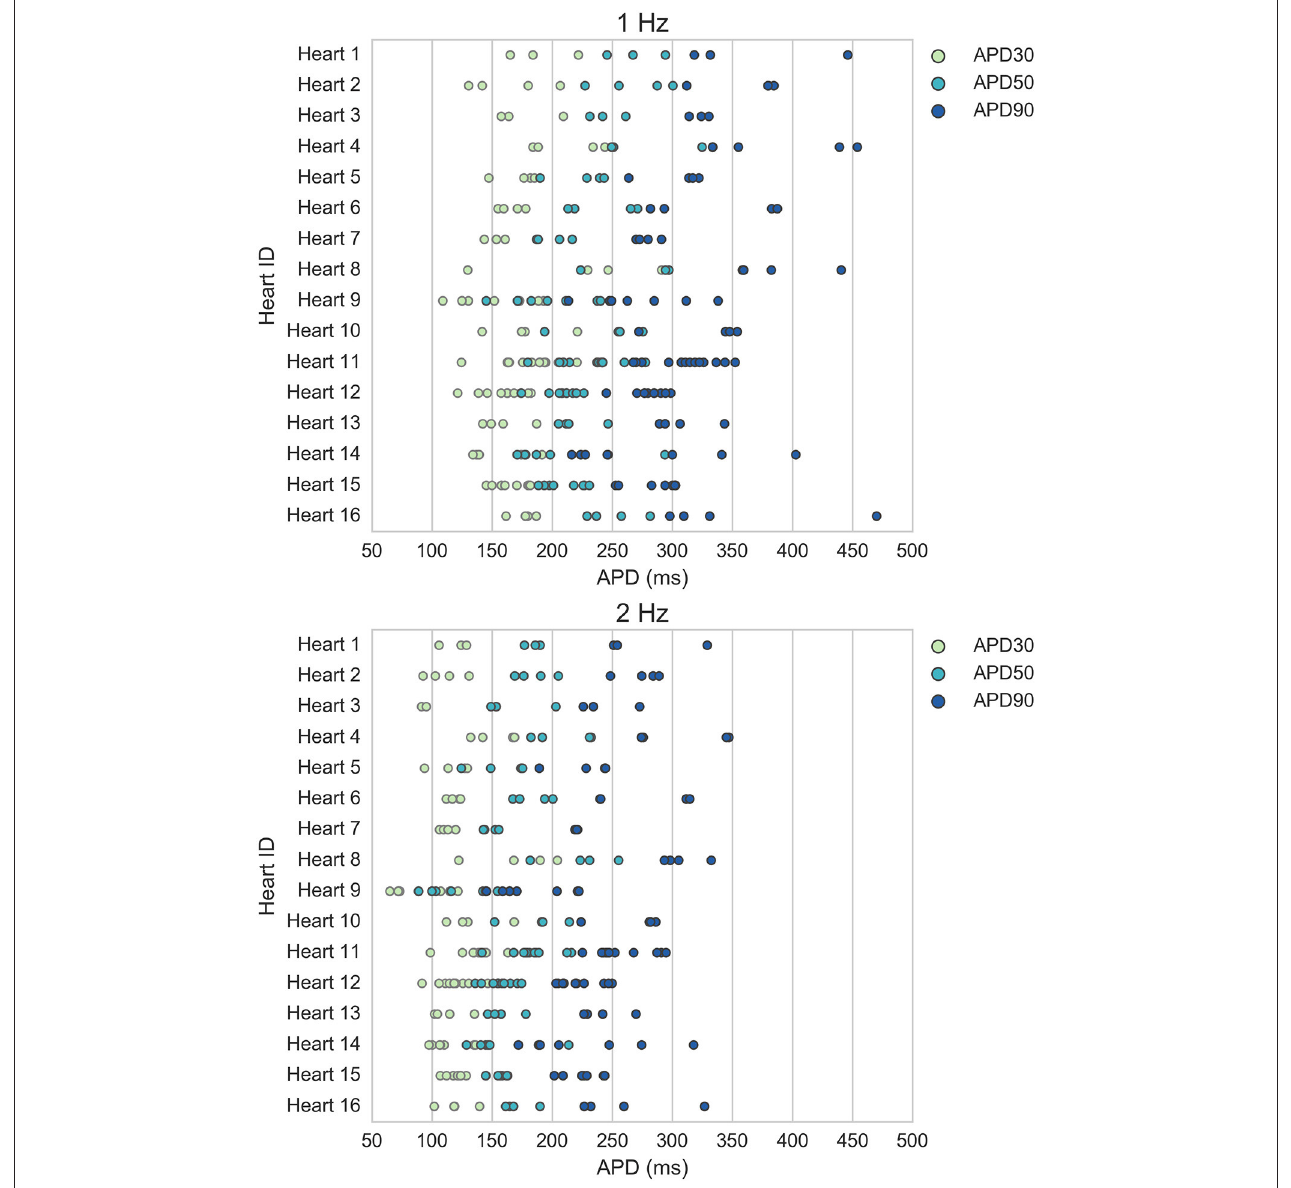
FIGURE 1 | Variability of APD30/50/90 values under control conditions for ventricular trabeculae from different donor hearts. Each dot indicates mean results of 30 action potentials from one trabeculae, each row represents data from a different donor heart. Top : 1 Hz pacing. Bottom : 2 Hz